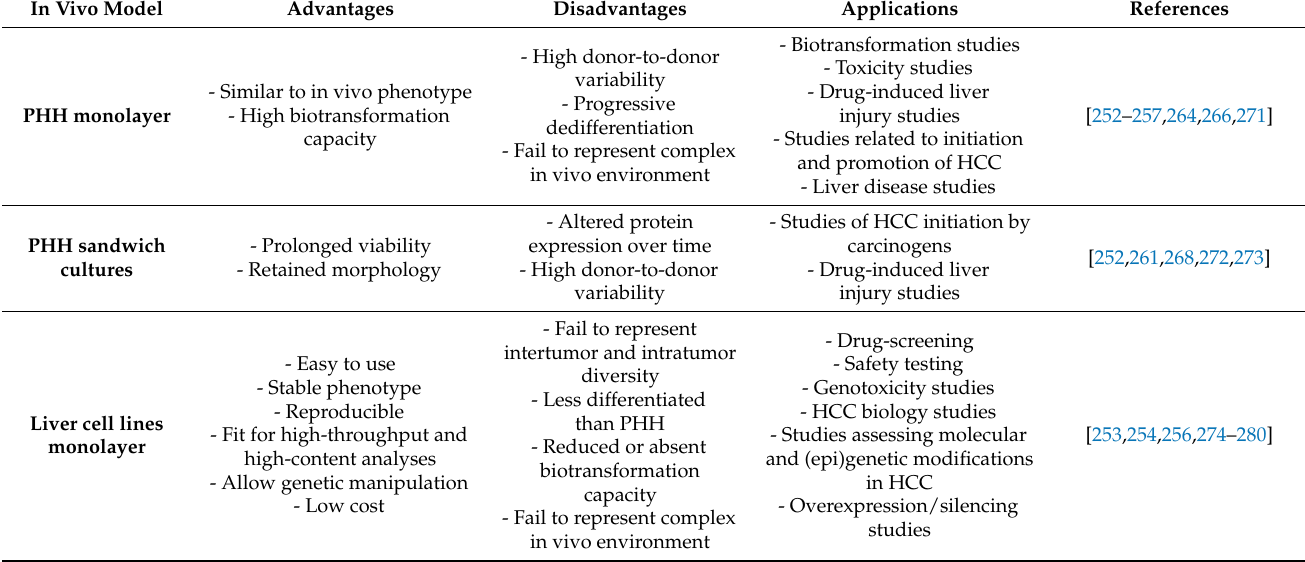
Table 7. Advantages, disadvantages and applications of commonly used liver-based in vitro models in liver cancer research. In Vivo